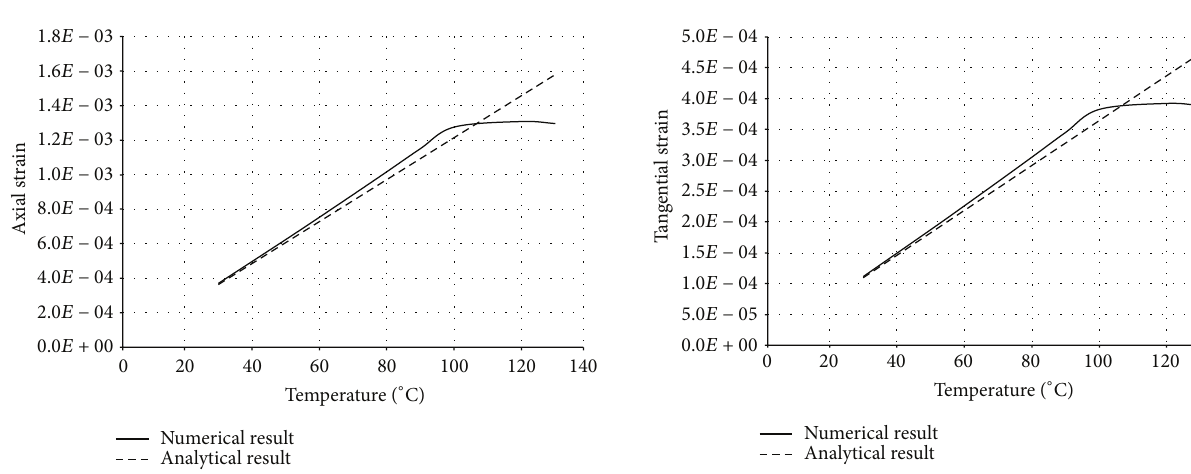
Figure 22: Comparison of axial strain in steel tube casing.